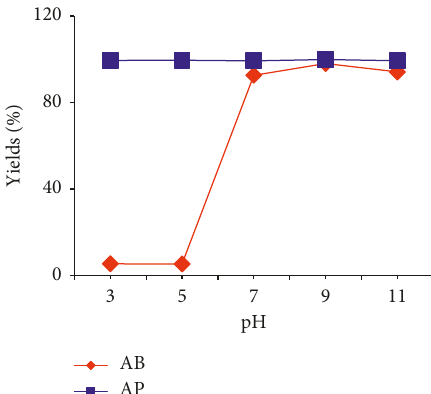
Figure 10: Influence of pH on the adsorption efficiency of methyl green by raw clay and purified Sejnane